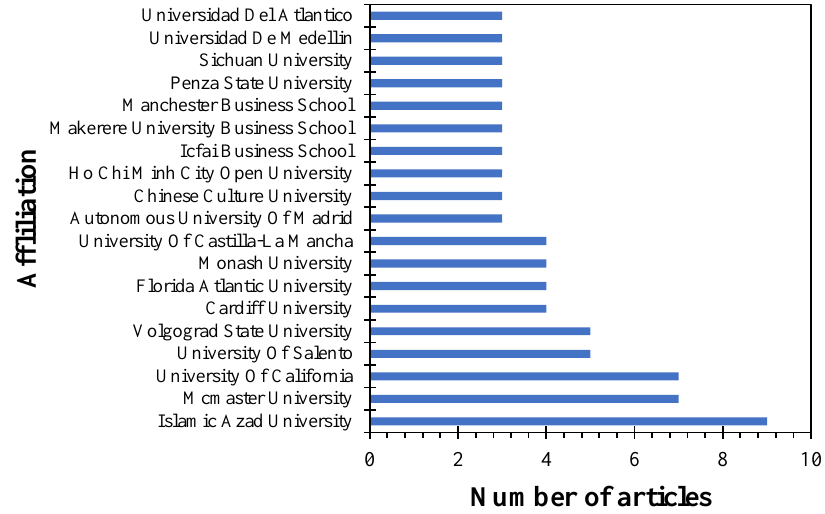
Figure 14. Top affiliation of institutions by authors.